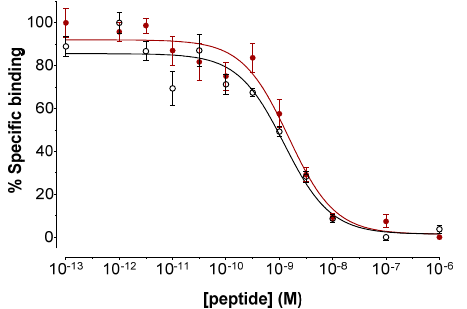
Figure 2. Displacement of [ 125 Tyr 25 ]LTT-SS28 from SST 2 R binding sites in HEK293-SST 2 R cell mem- brane homogenates by increasing concentrations of:  DATA 5m -LM4 (IC 50 = 1.24 ± 0.20 nM, n = 3);  [ nat Ga]Ga-DATA 5m -LM4 (IC 50 = 1.61 ± 0.32 nM, n = 3); results represent the average IC 50 values ± sd, n is the number of independent experiments performed in